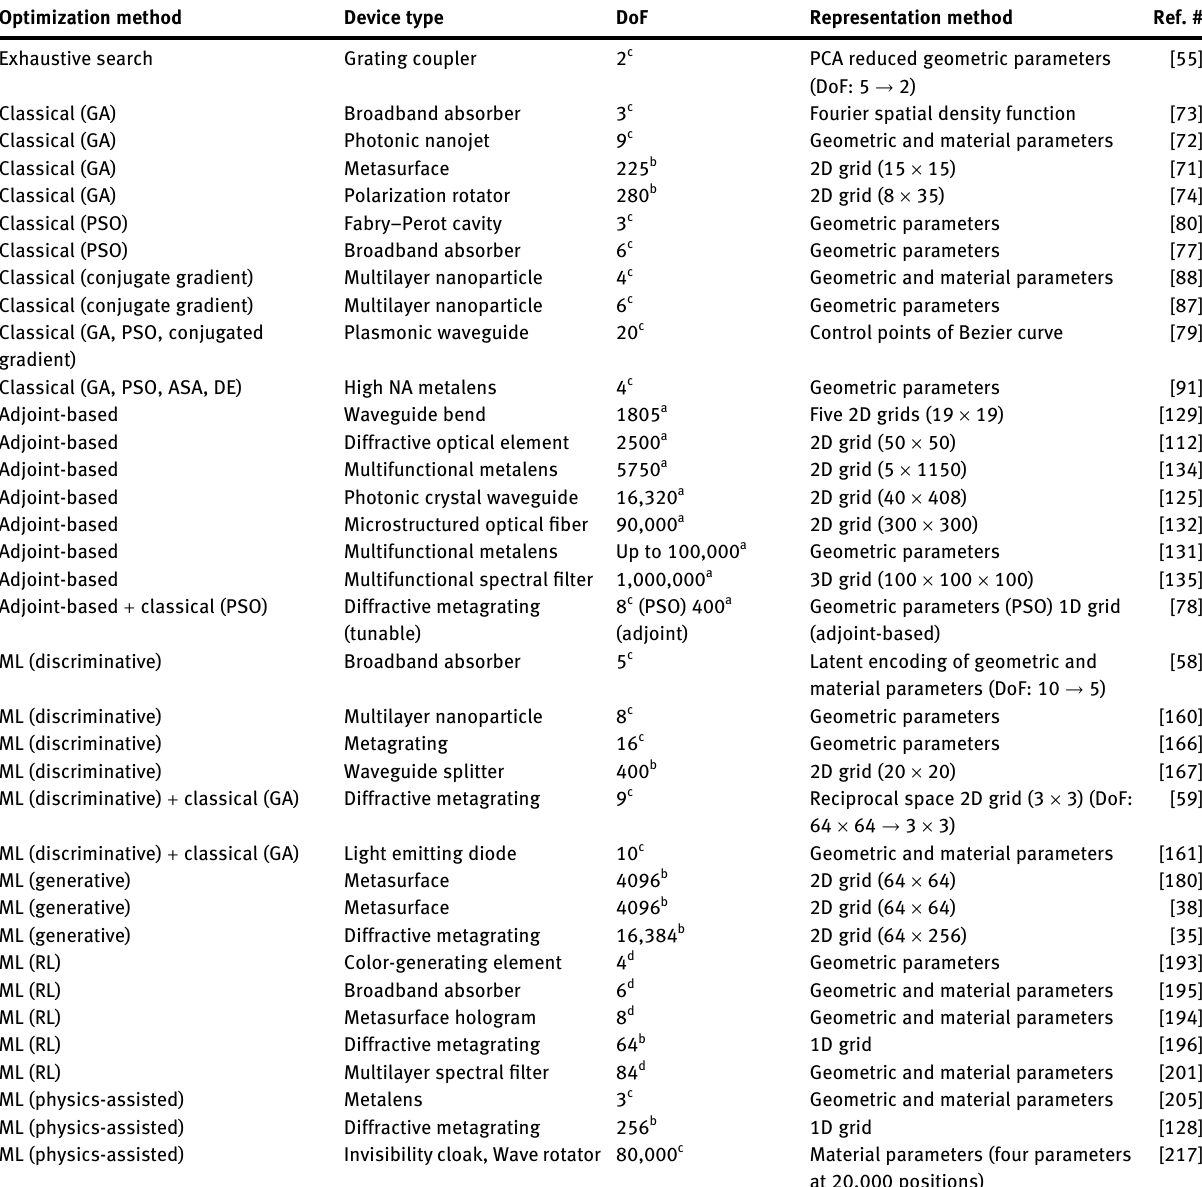
Table  : The optimization method, the device representation method, and the DoF of various nanophotonic device design problems. Works withoutaclearstatementonthedesignDoF,mostofwhicharebasedonthelevel-setrepresentationmethod,arenotincluded(a:continuous – binary pushed, b: binary, c: continuous, d: